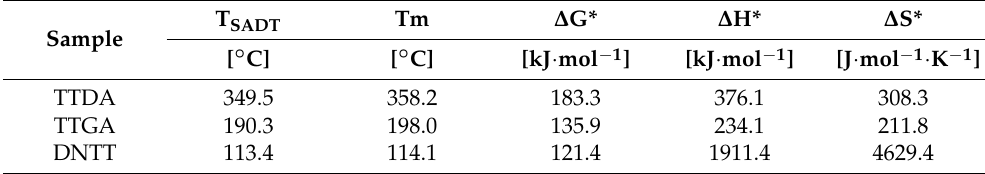
Table 15. Thermodynamic properties of the decomposition process in DTA cell.